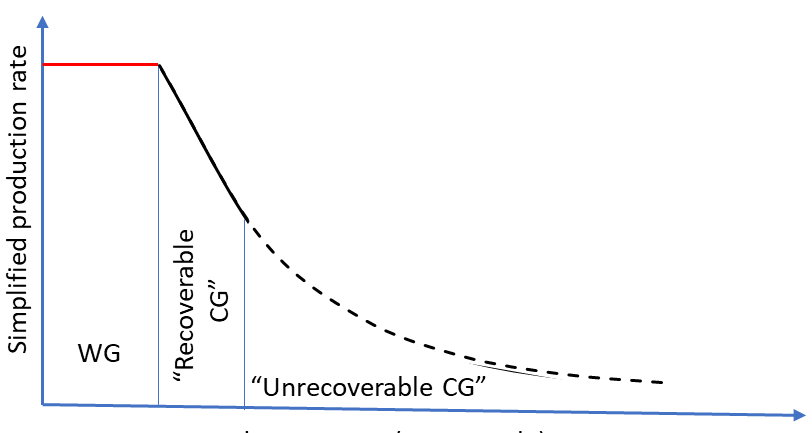
Figure 4. Simplified sketch to illustrate the redefinition of “recoverable CG”, the part of the CG that could be accessed by governments as emergency supplied. The WG production rate is controlled by the operator of the storage site. The production rate and pressure of the “recoverable CG” will decrease with time due to the depletion of the reservoir.